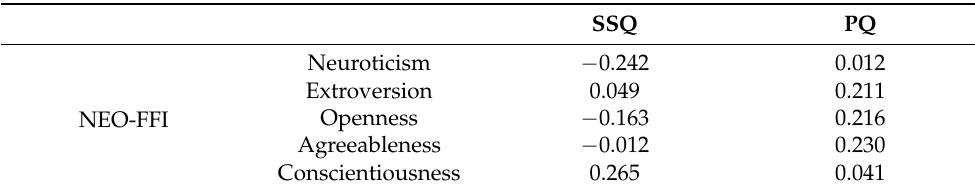
Table 3. Pearson’s correlations between the NEO-FFI, SSQ, and PQ. SSQ PQ Neuroticism − NEO-FFI